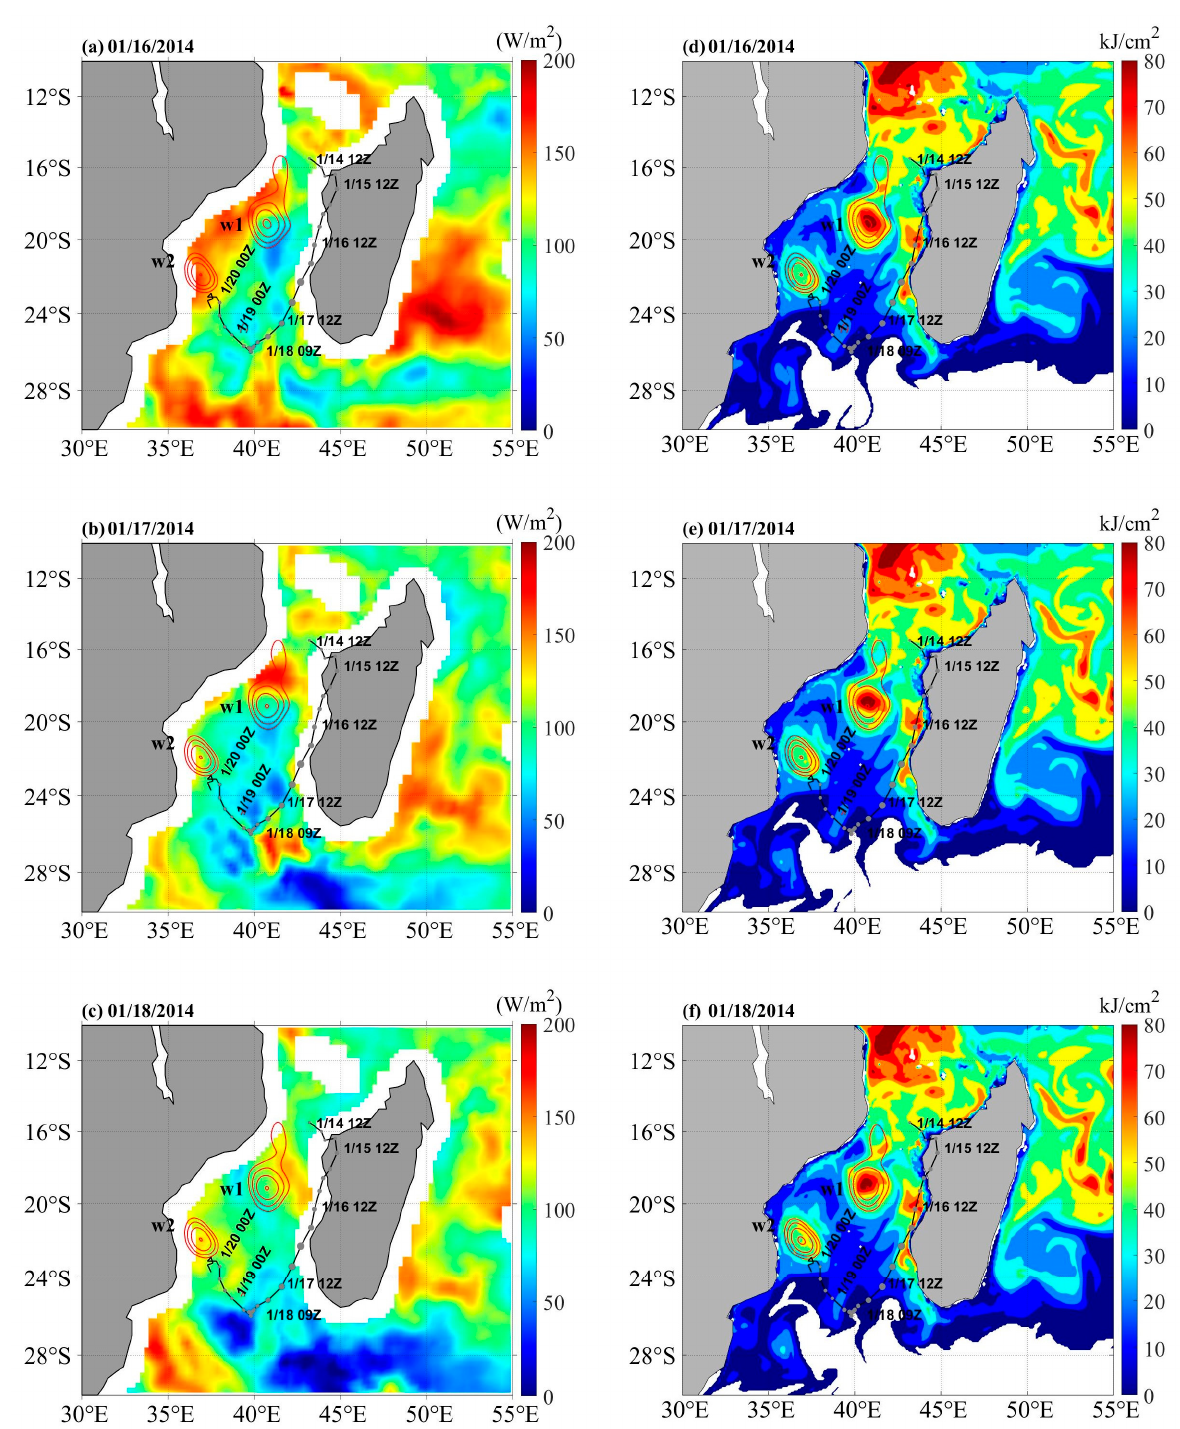
Figure 4. The ocean heat distribution during the development of the TS. ( a – c ) show the variation in latent heat flux from 16 to 18 January 2014; ( d – f ) show the change in TCHP from 16 to 18 January 2014.